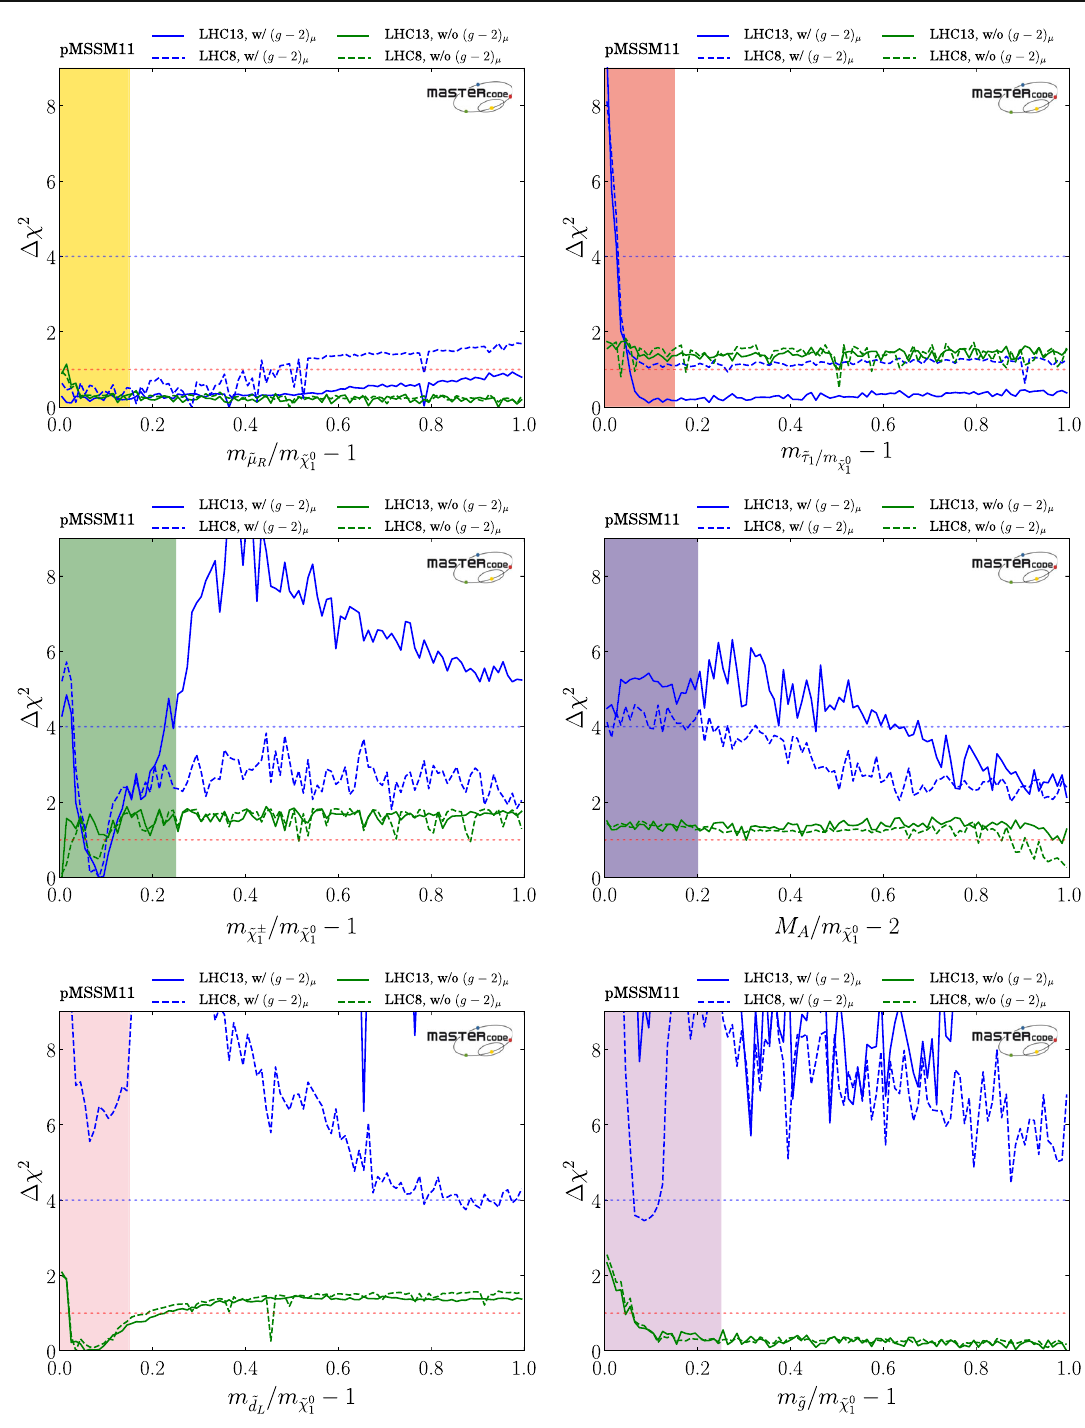
Fig. 17 One-dimensional profile likelihood plots for the measures of the prospective importance of ˜ μ R coannihilation (top left), ˜ τ 1 coannihi- lation (top right), ˜ χ ± coannihilation (middle left), rapid annihilation via 1